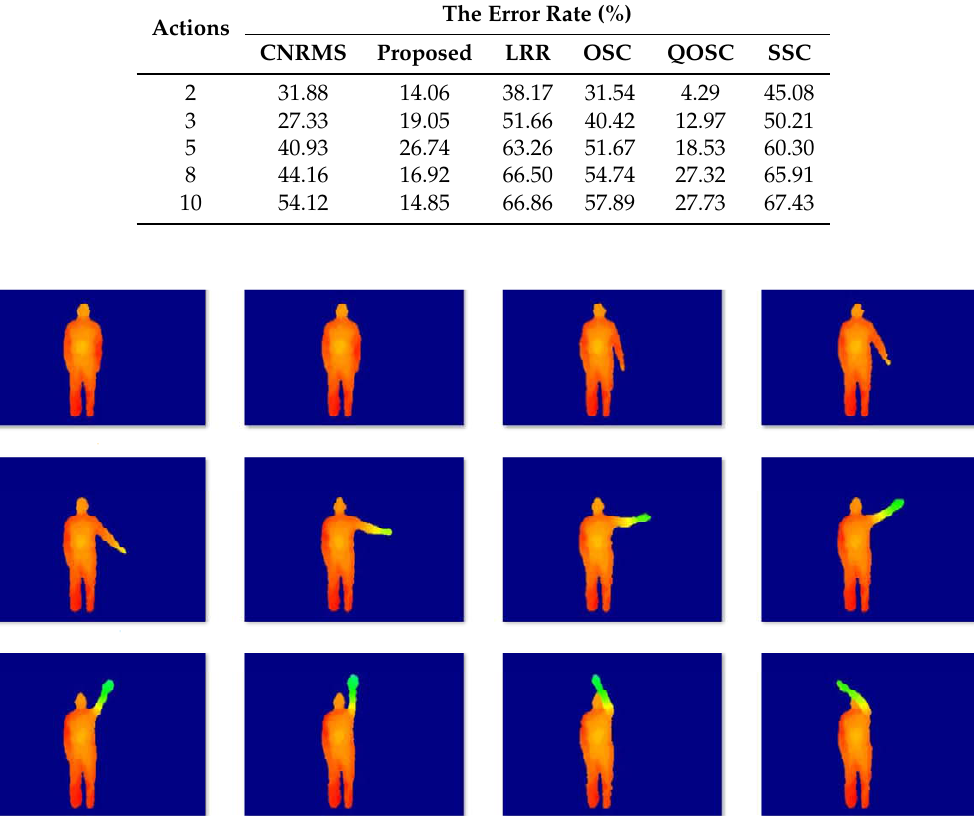
Figure 4. Sample images from the MSR Action3D